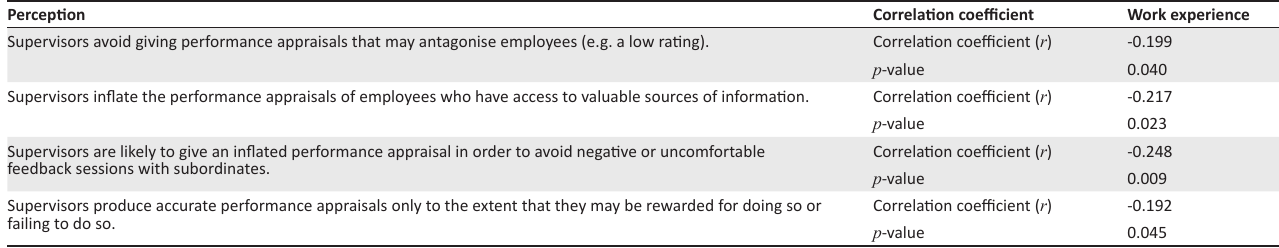
TABLE 2: Spearman’s rank correlation between work experience and perception of employees about performance appraisals.